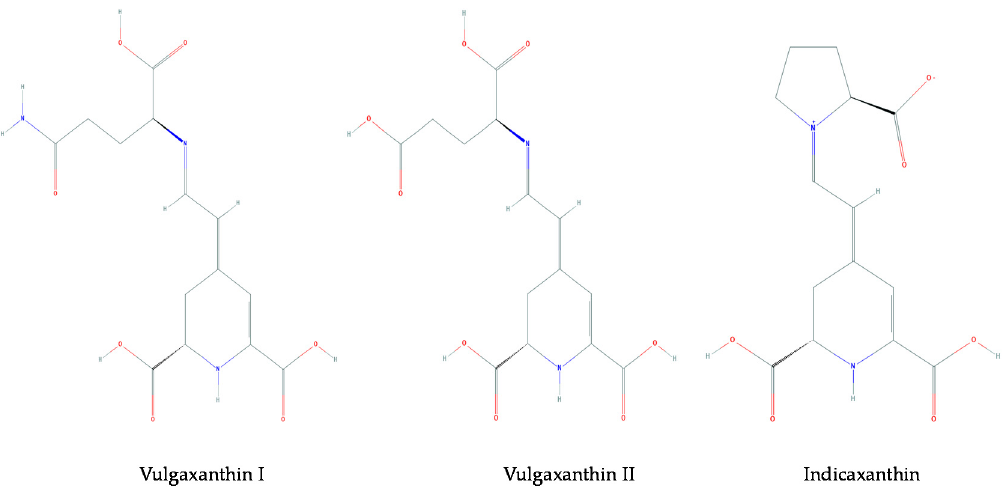
Figure 3. Chemical structure of the three main beetroot betaxanthins.